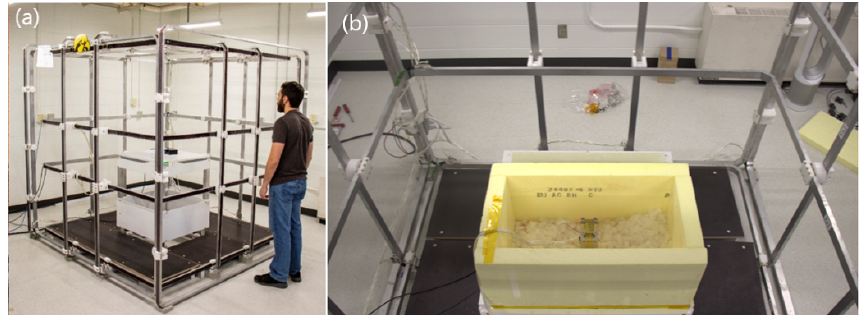
Figure 9. (a) The Tesseract prototype is secured in the center of a 2m Merritt coil system. This coil system is used to generate a field against which Tesseract can be calibrated. (b) The sensor is secured inside a polystyrene box, and the box is filled with dry ice and a Styrofoam lid is placed on top.